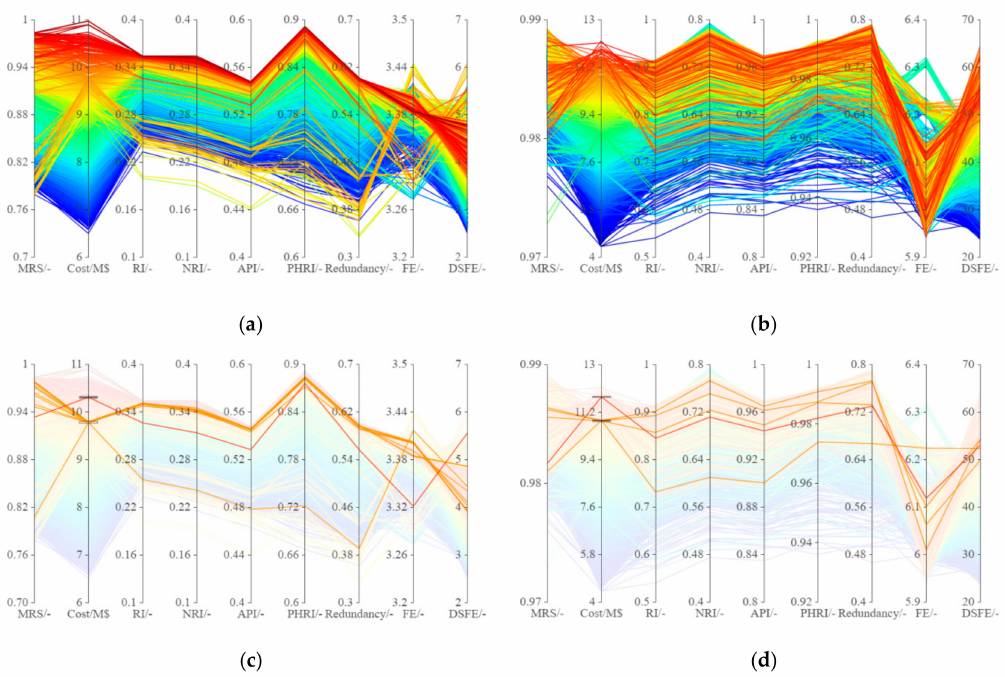
Figure 4. Parallel coordinate plots for the HAN and BIN design problems. ( a ) PCPs with all objectives and MRS for HAN; ( b ) PCPs with all objectives and MRS for HAN; ( c ) Representative solutions for HAN; ( d ) Representative solutions for BIN.